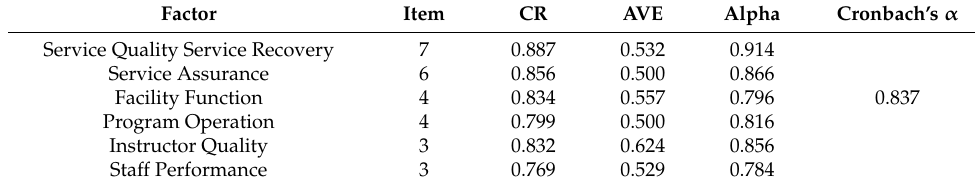
Table 5. Cronbach’s Alpha, CR, and AVE Coefficients of the Retained SFCS Factors.